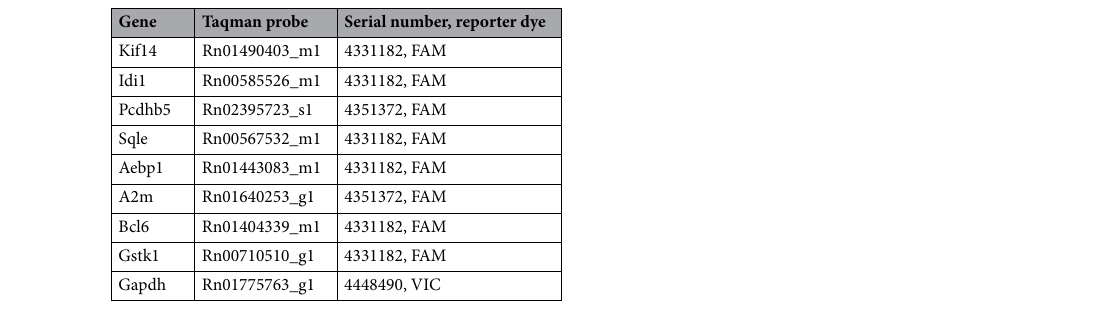
Table 2. Probes used to validate RNA